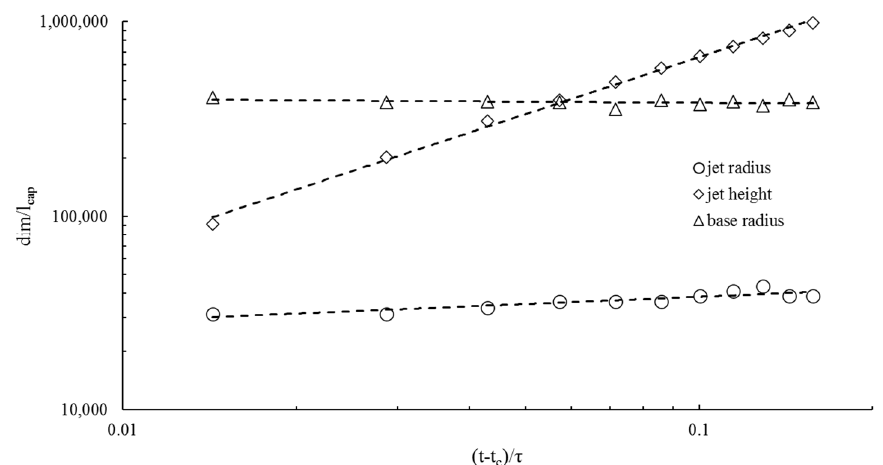
Figure 4. Log–log plot of dimensionless jet measurements versus dimensionless time of droplet of 40% G solution ( U i = 0.7004 m/s, We = 21.7, Re = 467.7) for jet tip radius (with power law fit r j / l cap ~(( t − t c )/ τ ) 0.12 ), jet height (with power law fit z j / l cap ~(( t − t c )/ τ ) 0.97 ), and base radius (with power law fit r b / l cap ~(( t − t c )/ τ ) 0.02 ).